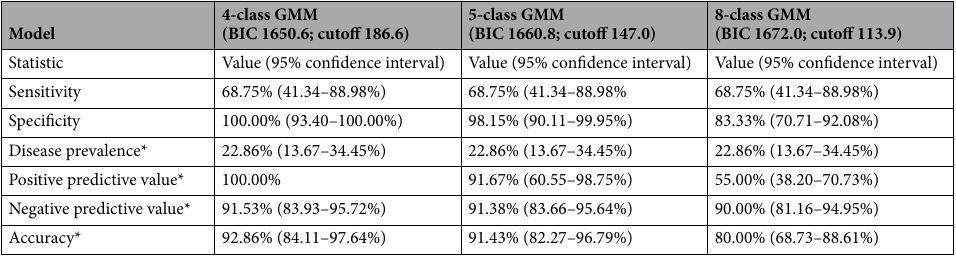
Table 3. Diagnostic performance of g3mclass solutions for ERBB2 mRNA test in DCIS. *These values are dependent on HER2+ disease